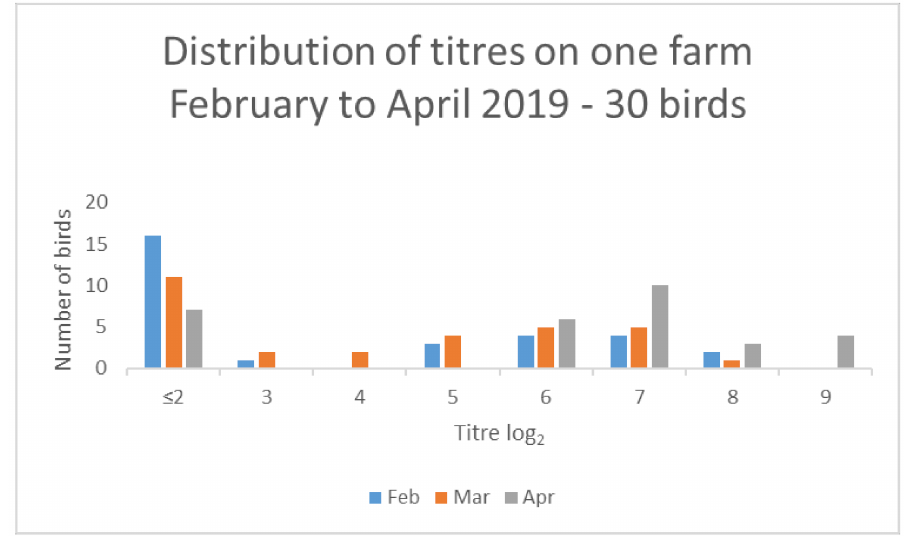
Figure 5. Results from one farm demonstrating changes in titre distribution for 30 birds over a 3-month